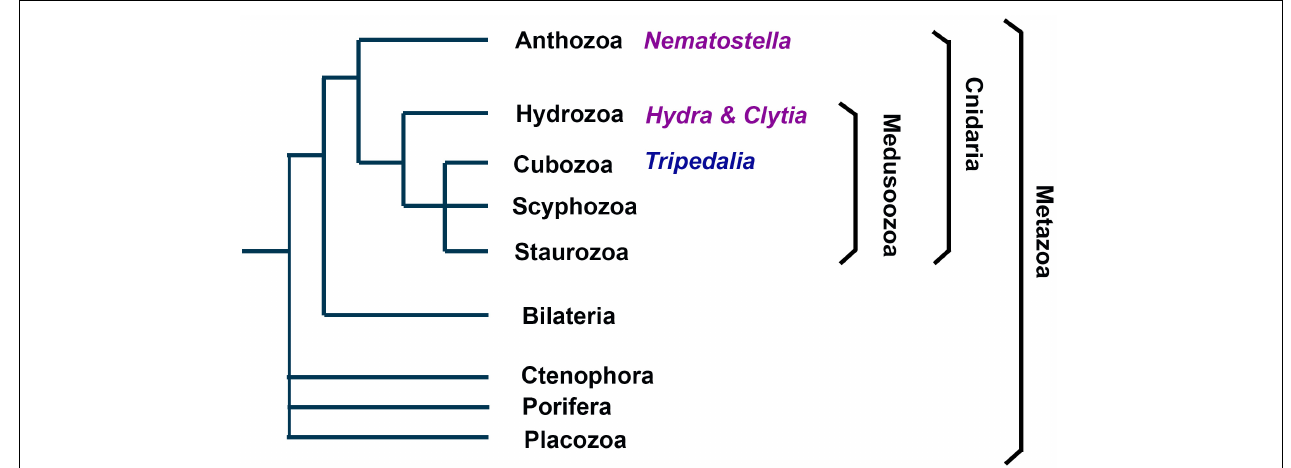
FIGURE 1 | Phylogenetic position and main clades of Cnidaria. As metazoans Cnidaria are the sister group of bilaterians. They comprise the subphylums Anthozoa and Medusozoa, each consisting of several clades. Anthozoa are thought to be the earliest branch among Cnidaria and do not have a medusoid life stage. Nematostella vectensis belongs to Anthozoa. Hydra and Clytia belong to Hydrozoan, which belong to the